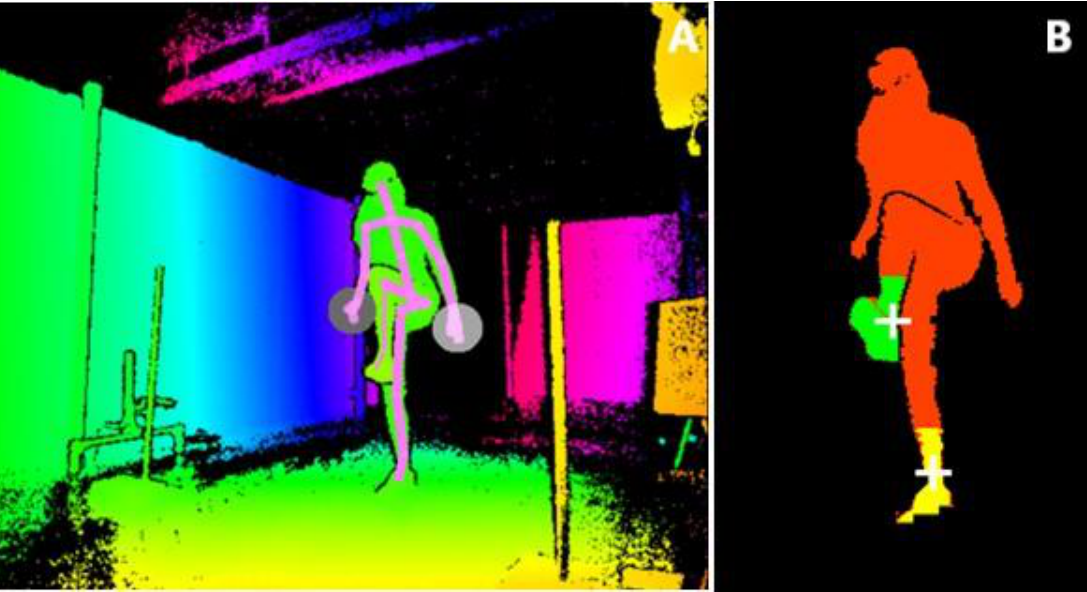
Figure 3. ( A ): Mirrored depth image from Kinect Studio with a superimposed stick figure based on the 25 body points of a participant avoiding a 3D holographic obstacle. ( B ): Extracted point clouds (mirrored) of left (yellow) and right (green) feet to determine step height and foot clearance with respect to the obstacle.